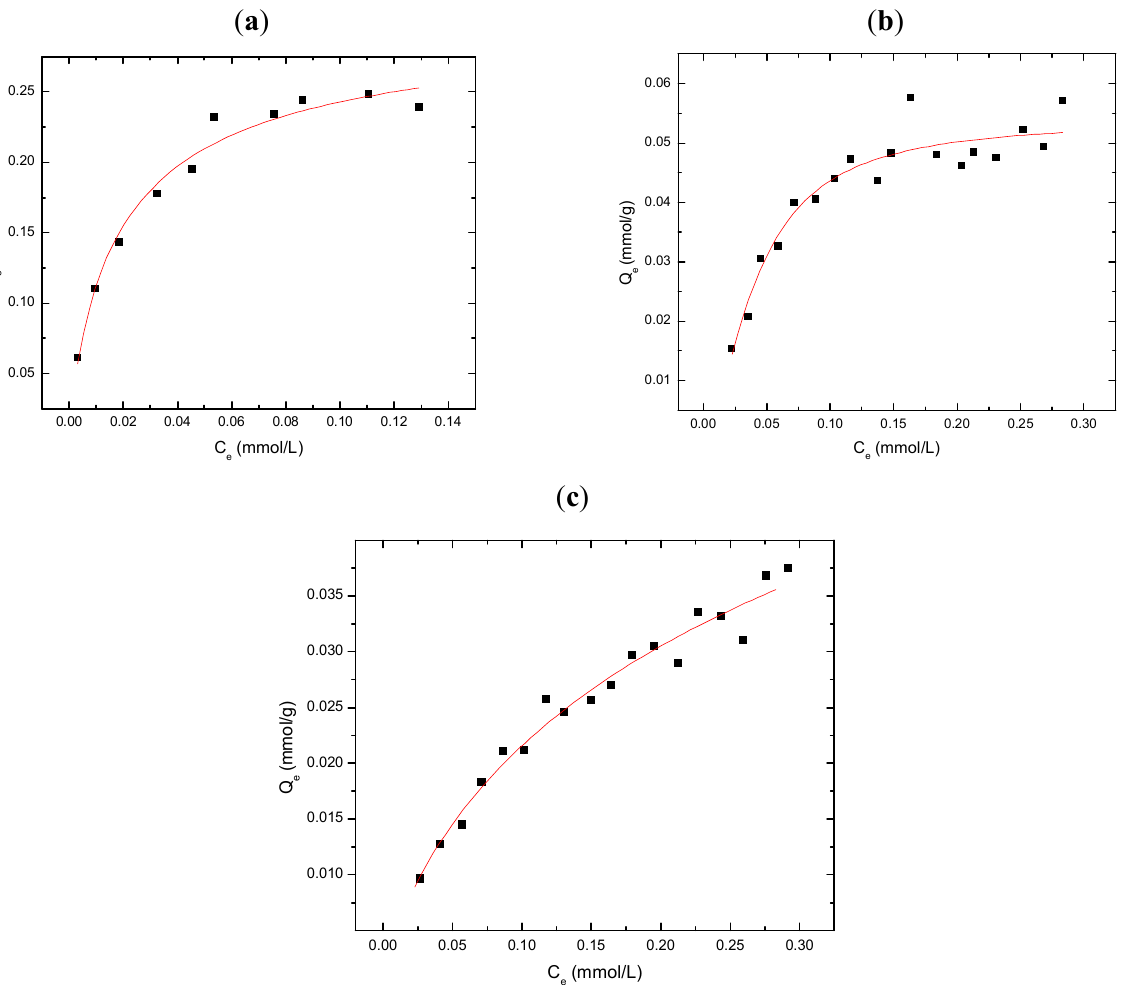
Figure 3. Sorption isotherms for PCP with various sorbents at pH 9.0 and 295 K; ( a ) GAC; ( b ) CDI-3; and ( c ) MDI-3. The solid line represents the best-fit curve according to the Sips isotherm (Equation